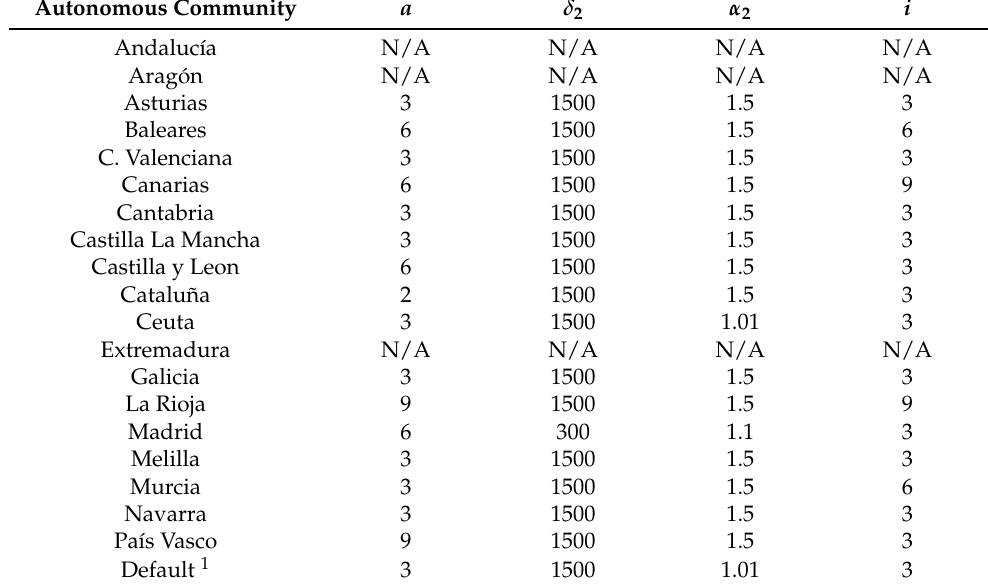
Table A2. Parameters for the proposed modified SVIR model per Autonomous Community. Autonomous